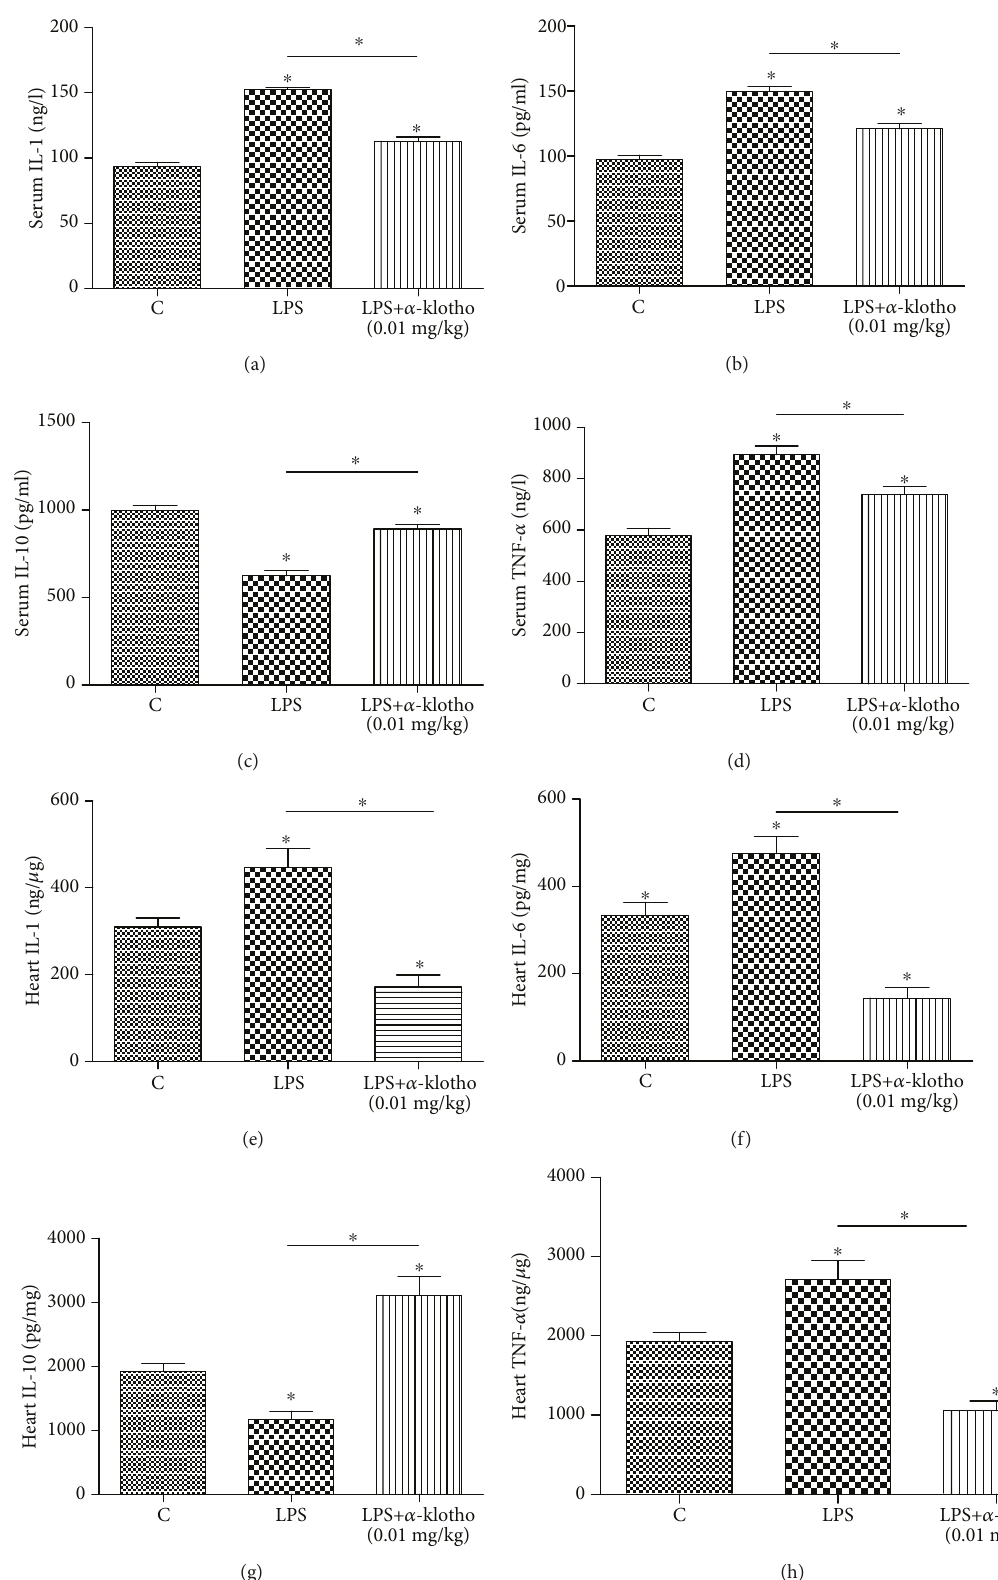
Figure 5: α -Klotho regulated cytokines in sepsis (a – h). Heart tissues and serum samples were collected at 24 h after LPS injection in the control group ( n = 6 ), LPS group ( n = 6 ), and LPS+ α -klotho (0.01 mg/kg) group ( n = 6 ). The levels of IL-1 (a, e), IL-6 (b, f), IL-10 (c, g), and TNF- α (d, h) were measured by ELISA. ∗ p < 0 05